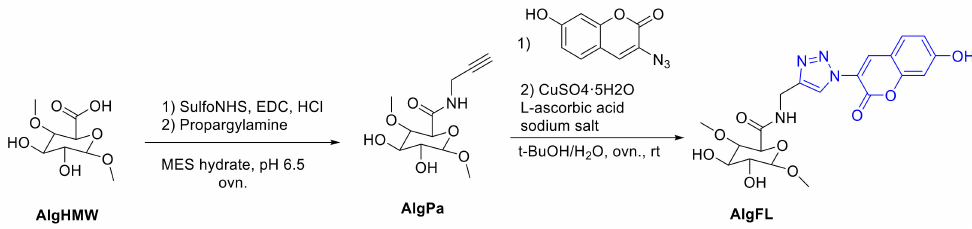
Figure 48. Synthetic route of fluorescent coumarin-grafted